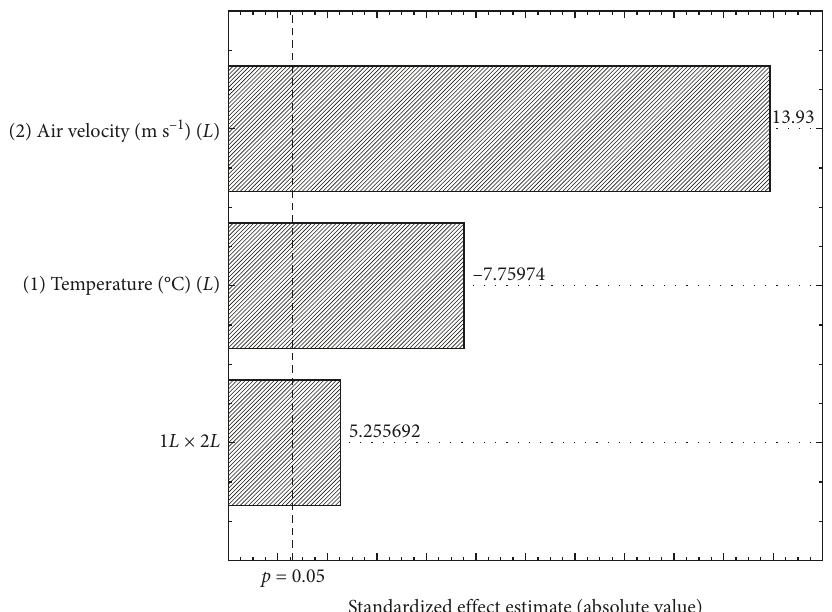
50 of the extracts.